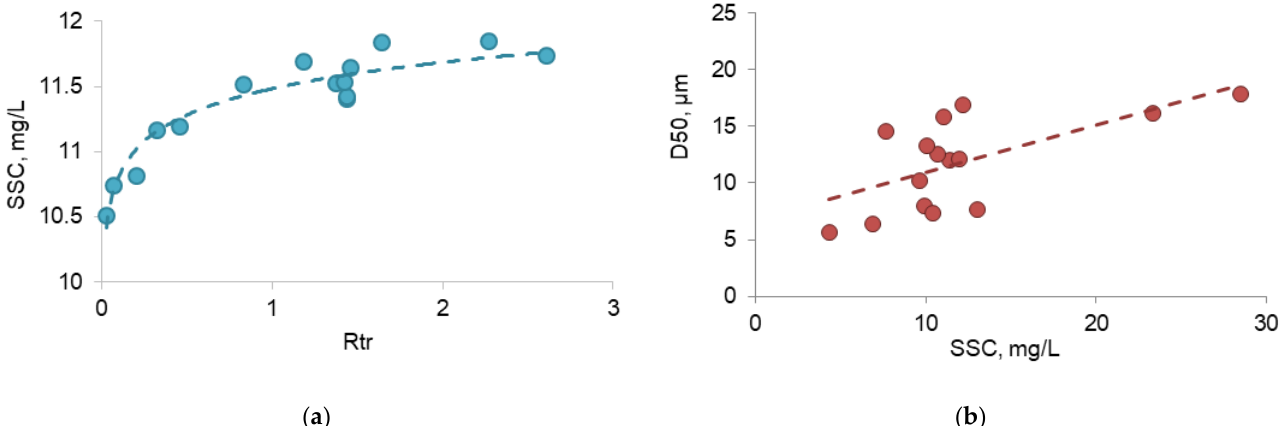
Figure 11. Relationship between the suspended sediment concentration ( SSC ) and ( a ) velocity (transport capacity — R tr ) from the measurements from 9 July 2016; ( b ) – mean sediment diameter ( D50 , µ m) from the measurement from 23 to 24 September 2021.